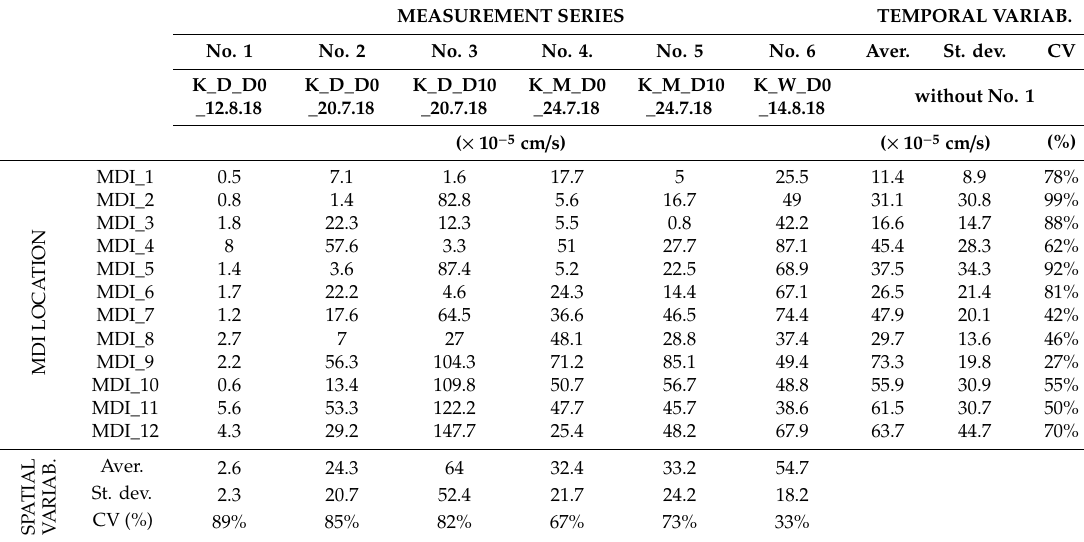
Table 1. Results of MDI